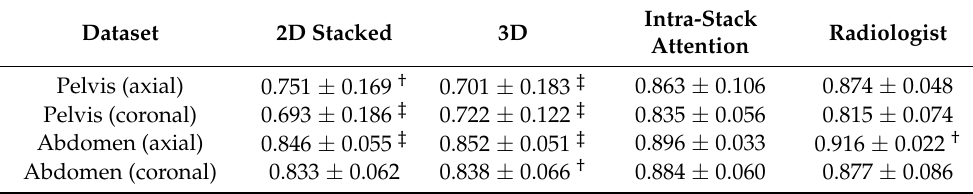
Table 1. Comparison of area intersection over union (IoU) averaged over cases.